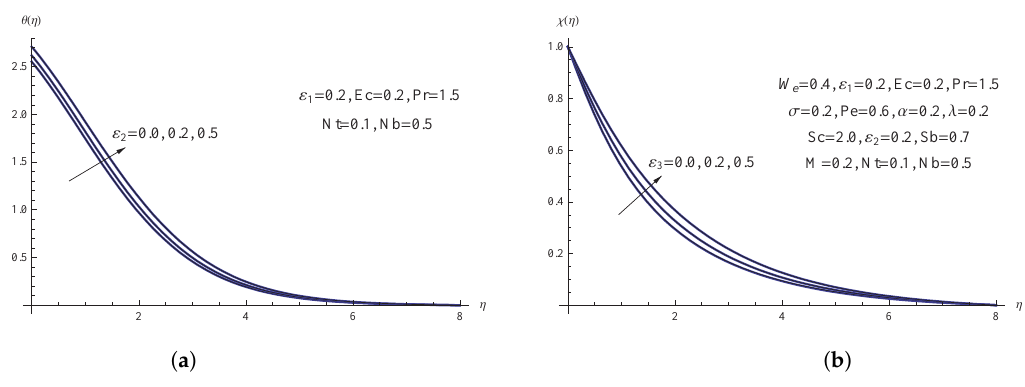
Figure 7. ( a ) θ ( η ) for various ε 2 . ( b ) χ ( η ) for various ε 3 . Finally, Figure 8, elucidates the impact of the Eckert number Ec on the velocity f (cid:48) ( η ) , temperature θ ( η ) , concentration φ ( η ) , and the microbe species concentration profile χ ( η ) plots, respectively. The bigger the value of Ec , the higher the temperature, sheet temperature θ ( 0 ) , concentration, and microbe species concentration sketches. The physics underlying this is that more energy is passed from surface to fluid due to a higher viscous dissipation phenomena. Furthermore, the velocity sketch f (cid:48) ( η ) decreases due to larger estimates of the Eckert number Ec , as seen in the same figure. The heat source resulting from the transformation of kinetic energy into internal thermal energy due to viscous stresses is accounted for by the viscous dissipation phenomena. Physically, the presence of viscous dissipation indicates the formation of thermal energy, which raises the sheet temperature, the thickness of the thermal boundary layer, and the temperature distribution.